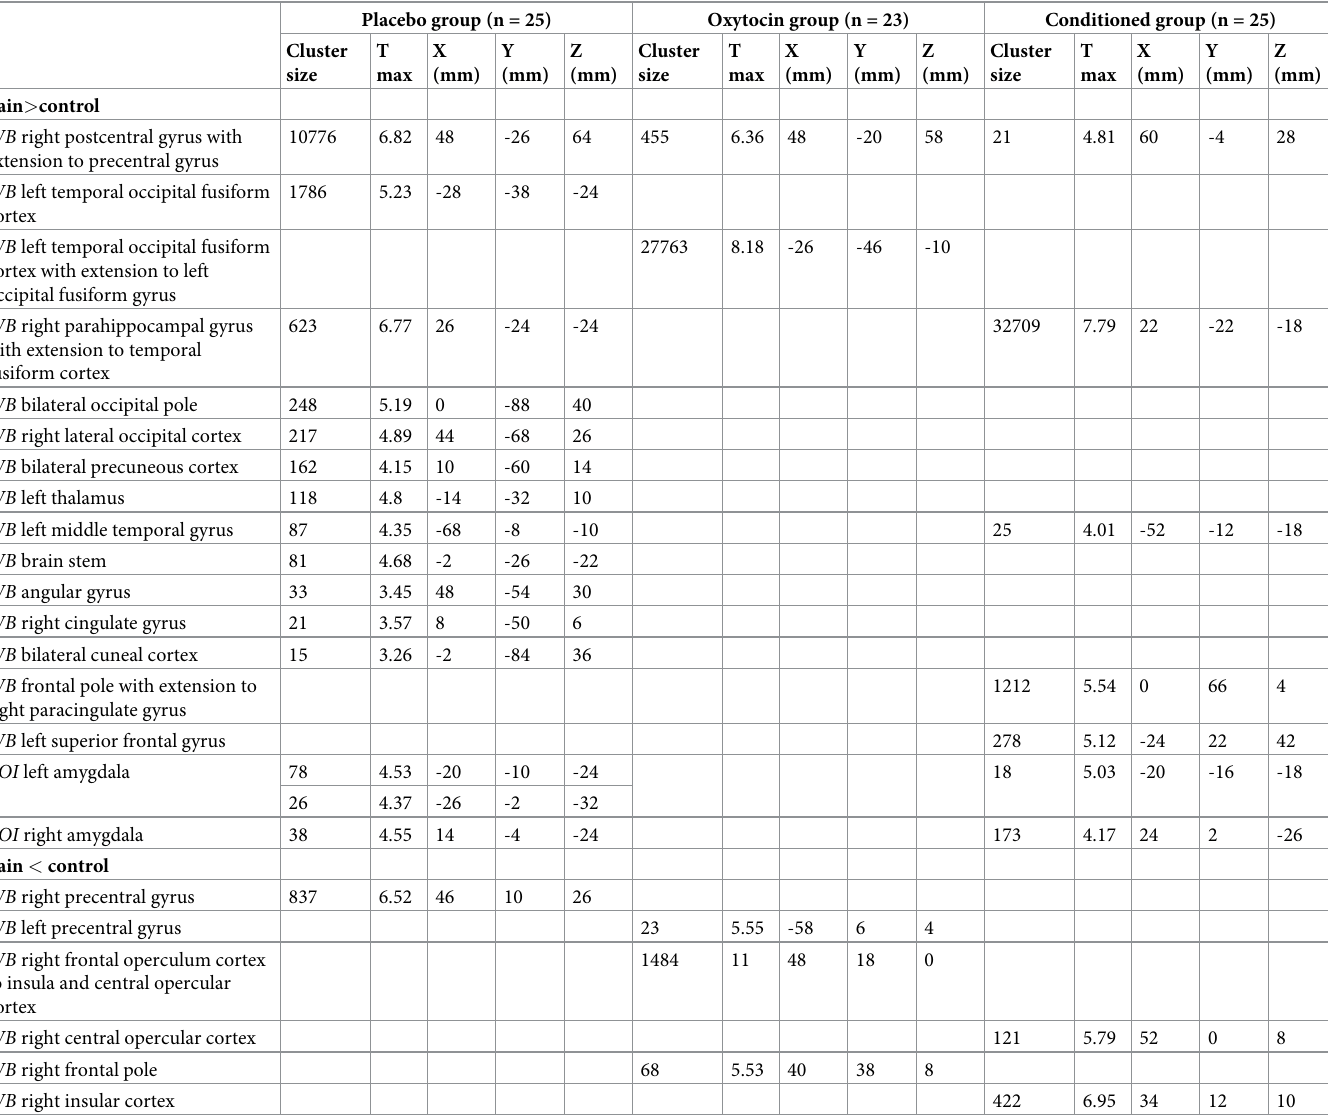
Table 4. Effects of the pain stimulation across the groups (second level analysis).